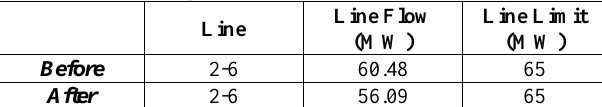
Table 4.Power flow in some critical lines before and